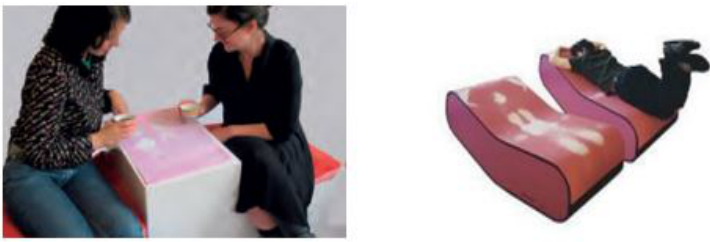
Figure 8. to the right the thermo- chromic bed (Ritter, 2007) , and to the left thermo- chromic pair chair with middle table (Mahdavinejad, Bemanian & Khaksar, 2011)